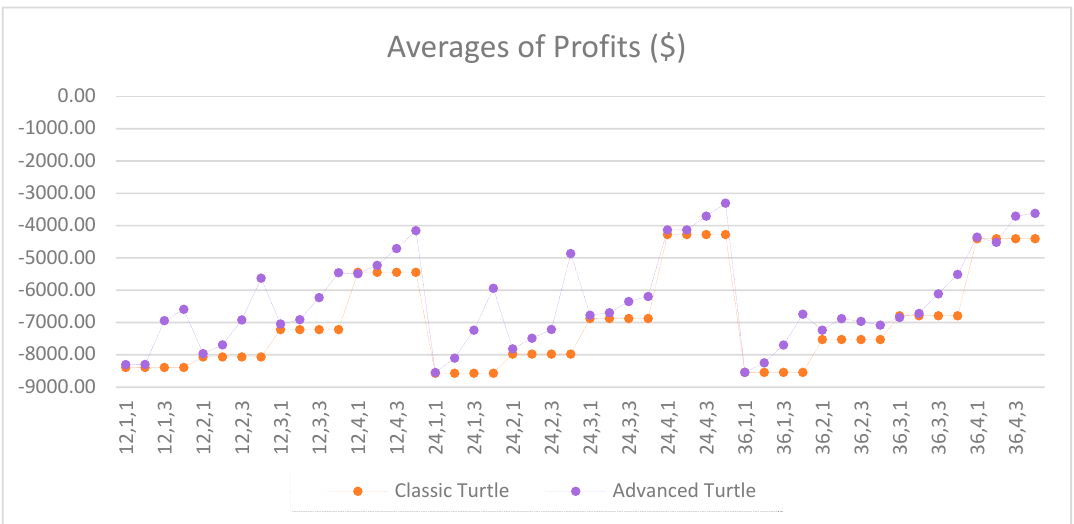
-9000.00-8000.00